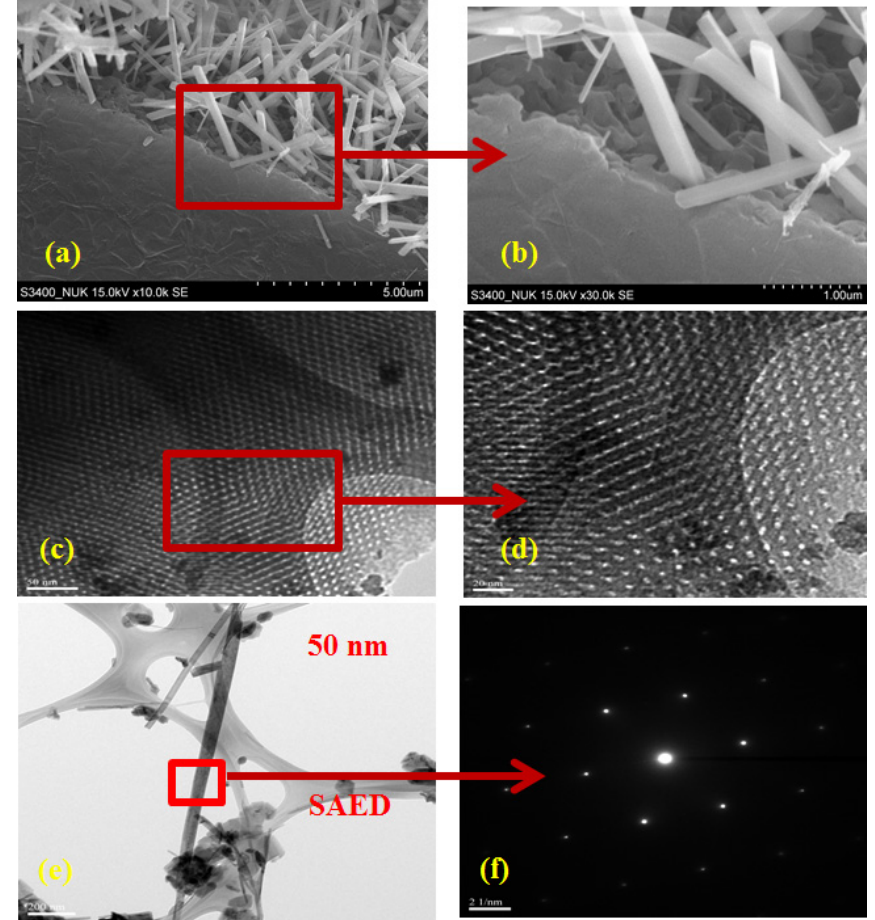
Figure 3. Scanning electron microscope (SEM) images ( a ) MnO 2 /C composites; ( b ) high magnification of the region marked with a square in ( a ); and transmission electron microscope (TEM) images ( c , e ) MnO 2 /C composites; ( d ) high magnification of the region marked with a square in ( c ); and ( f ) selected area electron diffraction (SAED) pattern of the region marked with a square in ( e ).